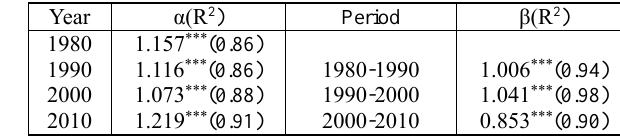
Table 7. Parameters and statistics of the Zipf’s and Gibrat’s model of cities in YRD